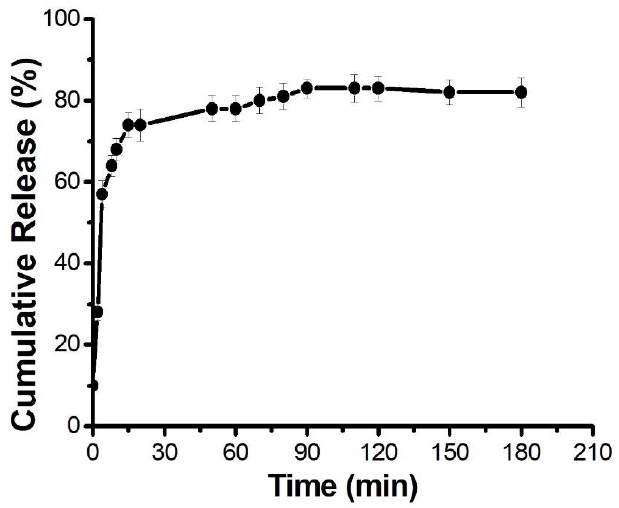
Figure 2. The release of myricetin from the liposomal nanoencapsulation at different time intervals.